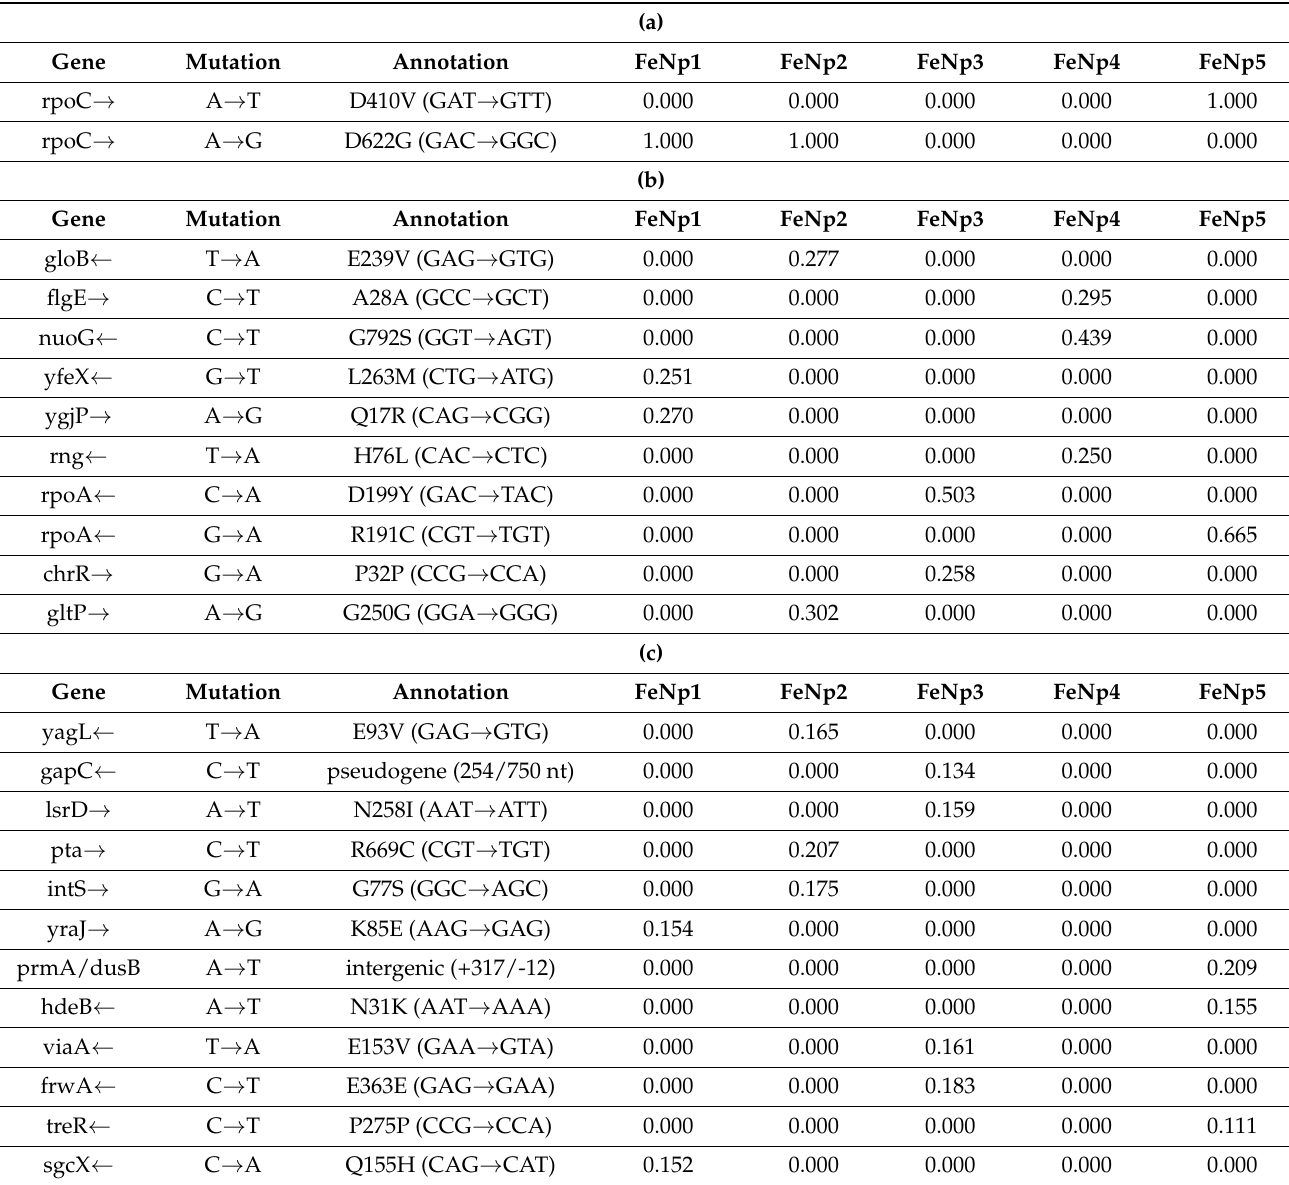
Table 3. ( a ) Selective sweeps in FeNP-resistant populations at day 25. ( b ) Significant polymorphisms in FeNP-resistant populations at day 25. ( c ) Minor polymorphisms in FeNP-resistant populations at day 25.